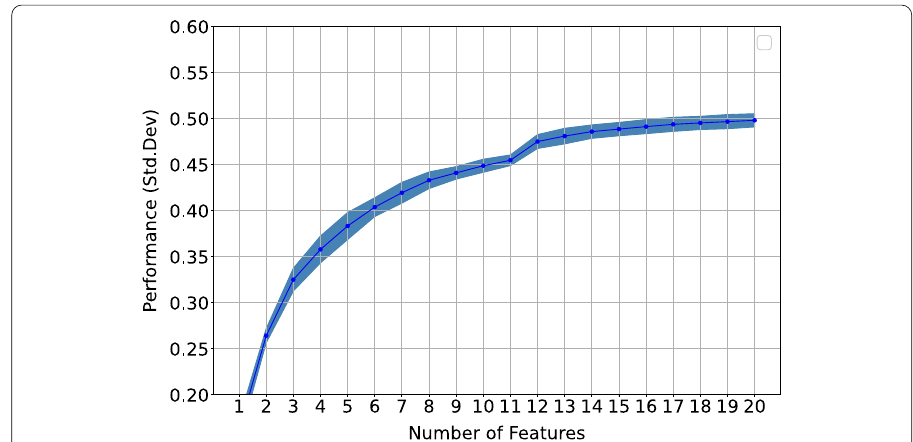
Fig. 9 Sequential forward floating selection linear regression with top 20 most important variables